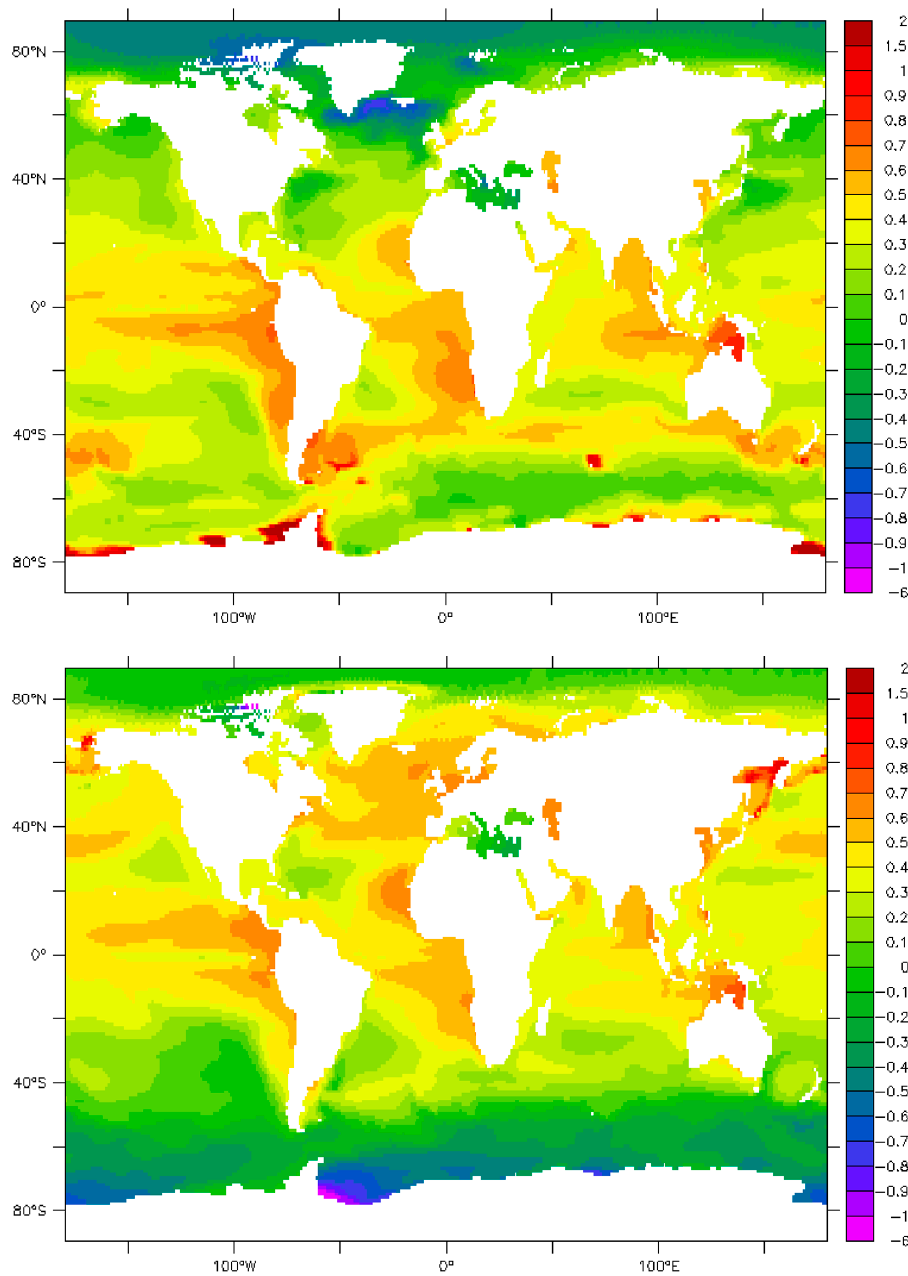
Figure 1. Log surface pressure maps ( Δ tension) assembled using the baseline Ogunro et al. model output [33] plus marine 2D equations of state described in Appendix A. The color bar has been set so a reference range of 0.3–3 mN/m is central ( − 0.5 to 0.5 in log units). February and August monthly averages are shown for a typical year near the turn of the millennium.